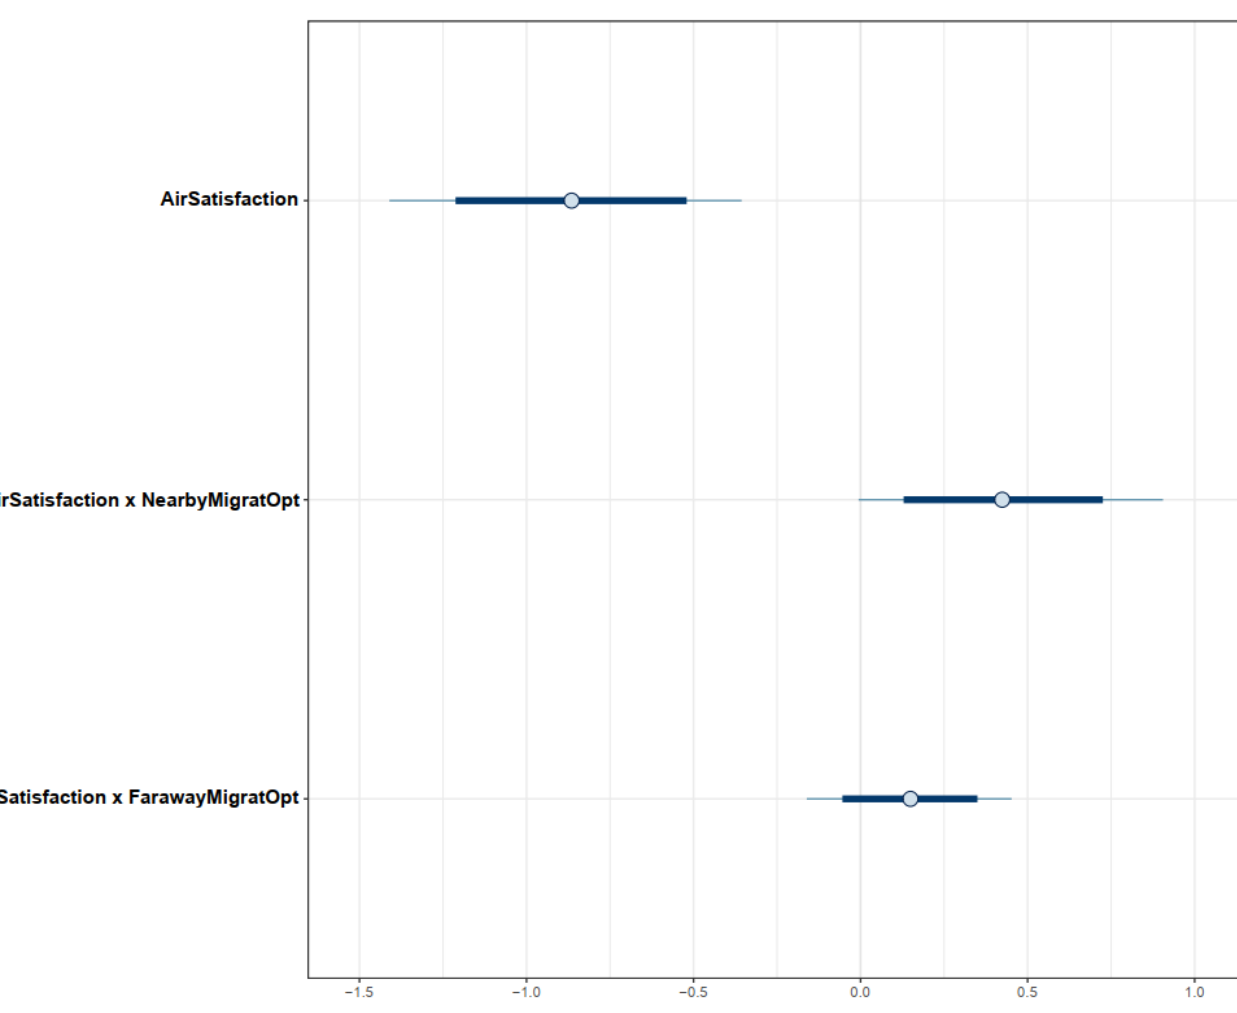
Figure 4. Distributions of Model 1’s posterior coefficients on an interval plot.